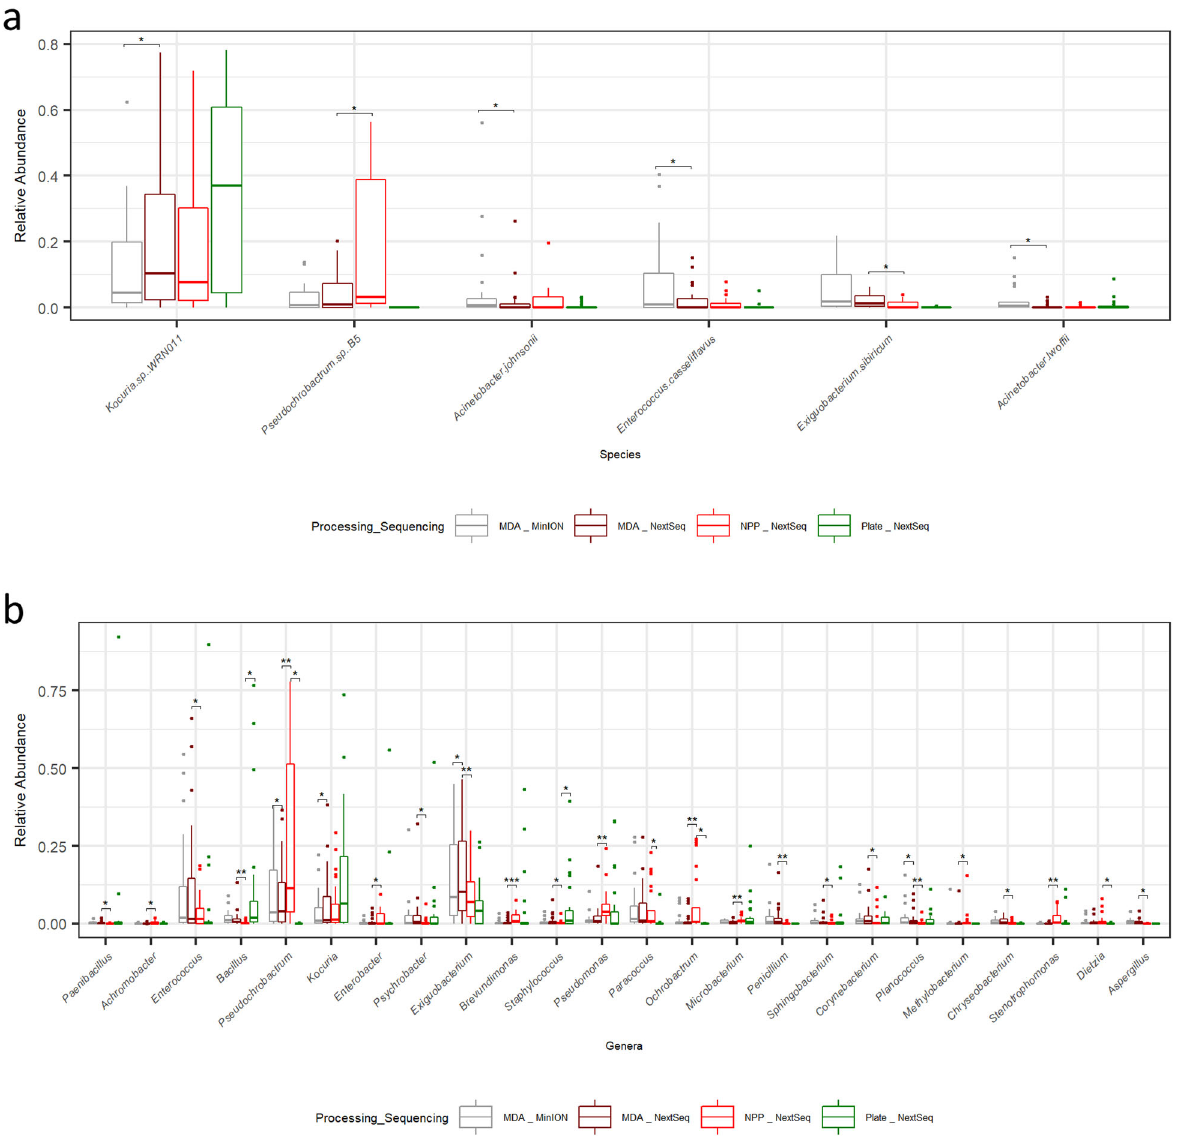
Fig. 6 Signi fi cant differences in the relative abundance of taxa based on processing and sequencing method. a Signi fi cant species level differences due to sequencing and processing methods on environmental samples. Controls are excluded from these calculations and fi gures. b Signi fi cant genera level differences in relative abundance due to sequencing and processing methods on environmental samples. Controls are excluded from these calculations and fi gures. Boxplot centre line, median; box limits, upper and lower quartiles; whiskers, 1.5x interquartile range; points, outliers (*** = p < 0.001, ** = p < 0.01, * = p <